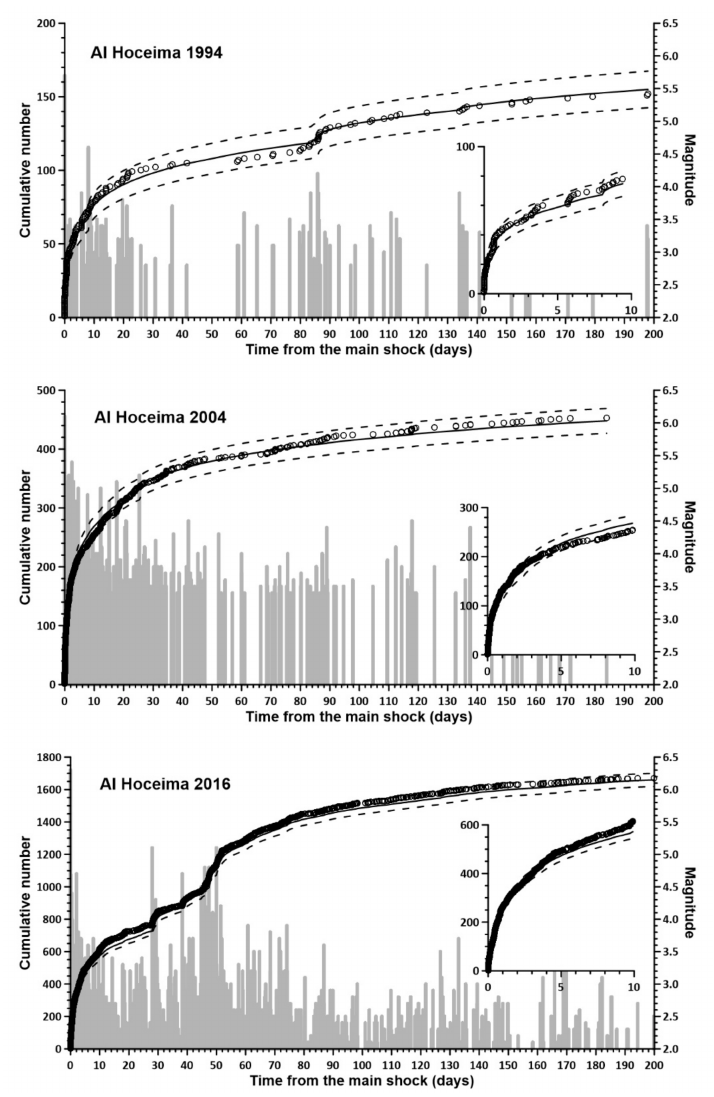
Figure 11. The cumulative number of events above magnitude m c for the three sequences. Circles: σ fitted model. The magnitudes of the events included in the observed values. Lines: mean ± sequences are also depicted. Inset stand out the first ten days of the